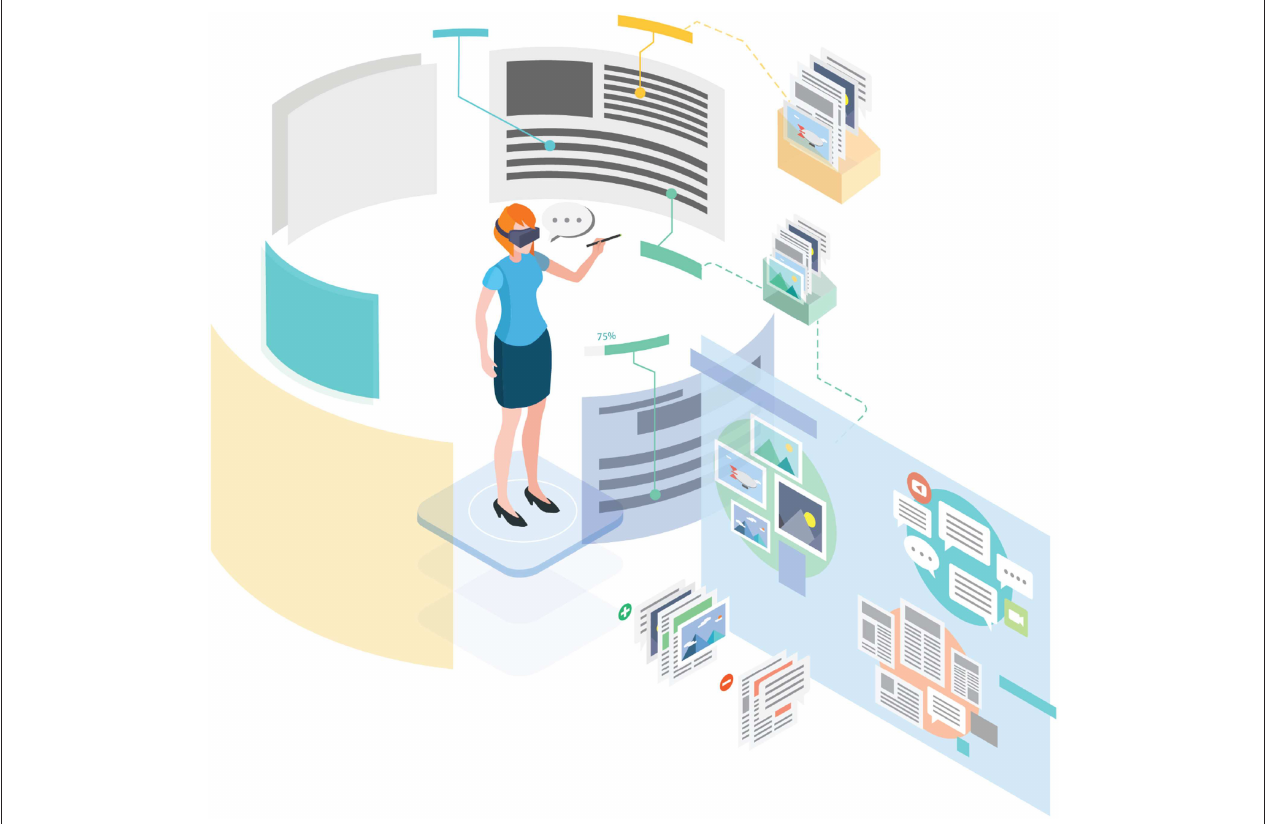
FIGURE 7 | Conceptual illustration of Immersive Space to Think (IST). A human analyst uses immersive space to organize her thinking about a complex set of documents and data. The system observes interaction to recognize clusters created by the user, understand what is relevant to the user, and infer the user’s hypotheses. Based on these semantic interactions, underlying machine intelligence algorithms suggest new data to consider, summarize data, and label data (e.g., with estimated credibility).